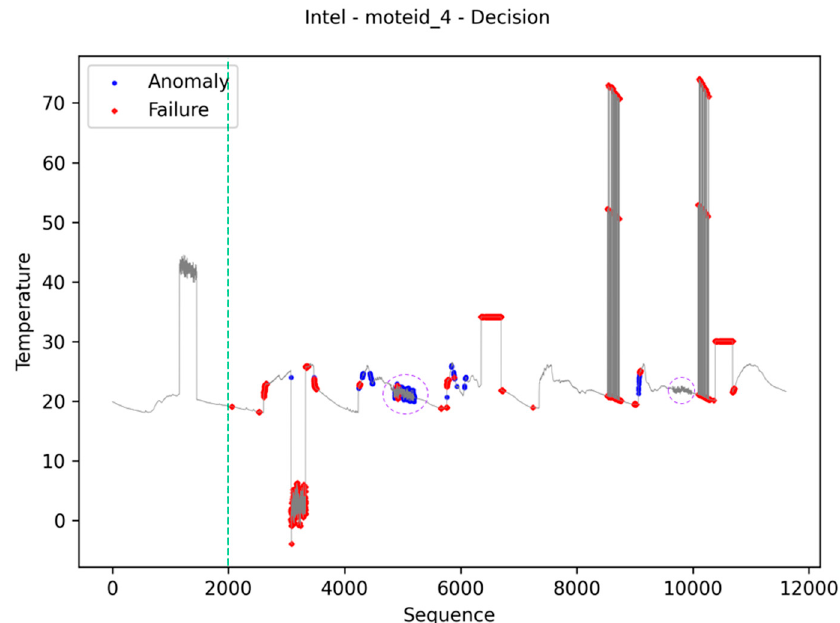
Figure 12. Intel dataset: online, up-to-date, and data identification results.